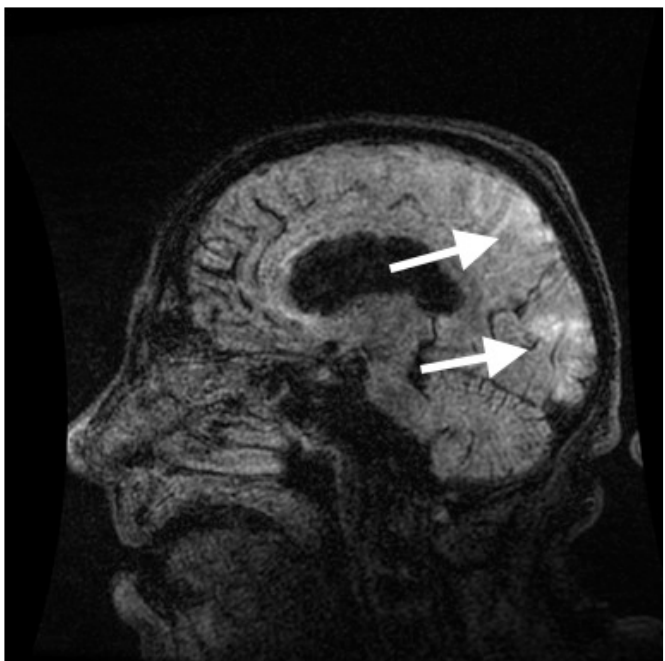
Figure 2. T2 weighted magnetic resonance imaging of Patient 2, with hyperintensity of posterior parietal and occipital